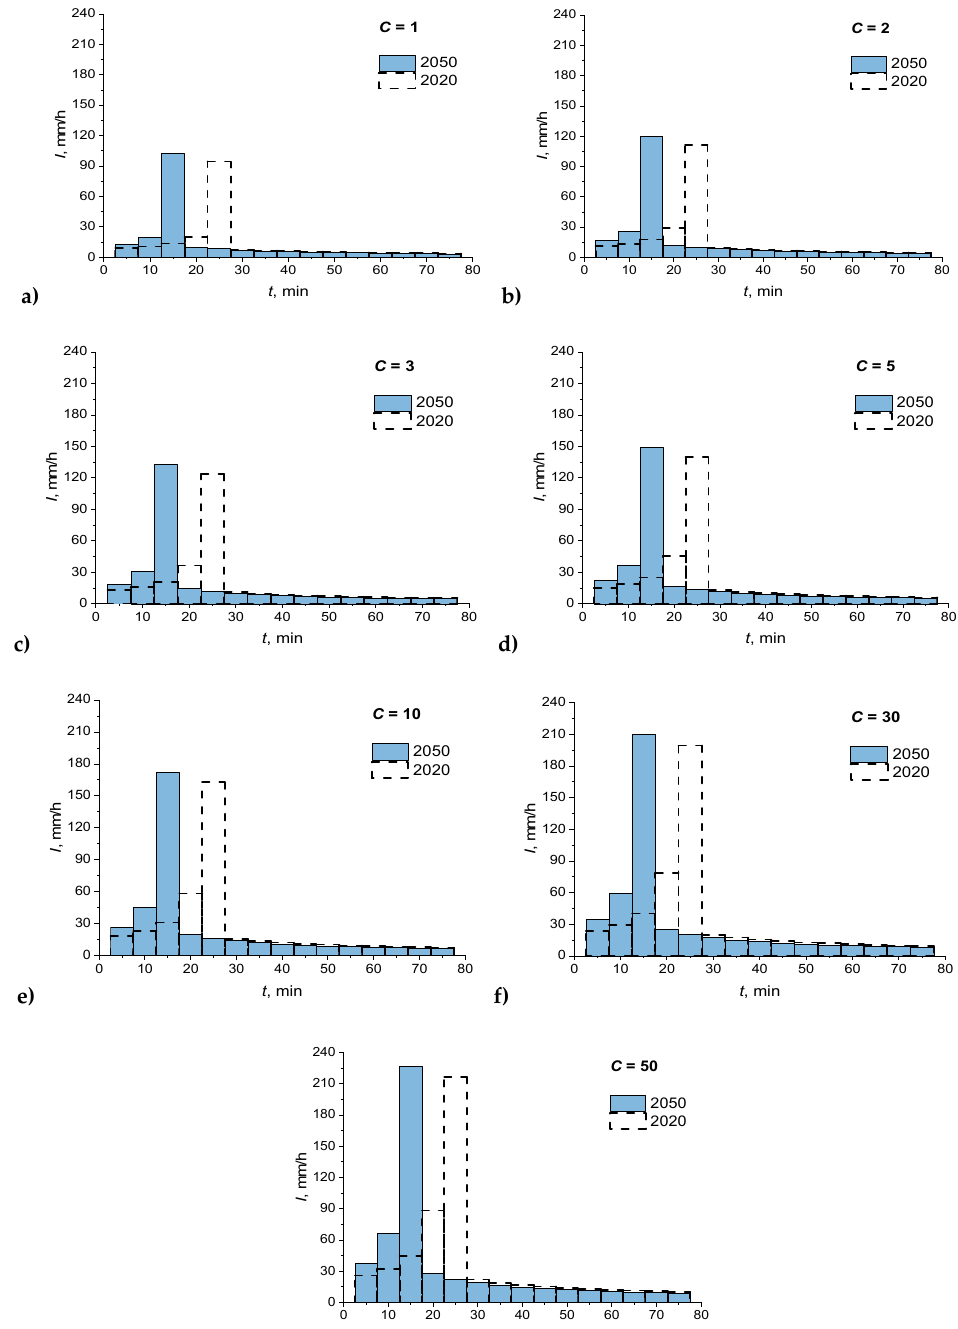
Figure 6. Examples of the generalized short duration precipitation models with duration t = 75 min developed for 2050 (blue bars) against the background of the current Euler type II model for 2020 (dashed line), for occurrence frequency ( a ) C = 1 ( b ) C = 2 ( c ) C = 3 ( d ) C = 5 ( e ) C = 10 ( f ) C = 30 (g) C = 50 years for modelling overloads of the stormwater drainage system in Wroc ł aw, according to the requirements of standard EN 752:2017.